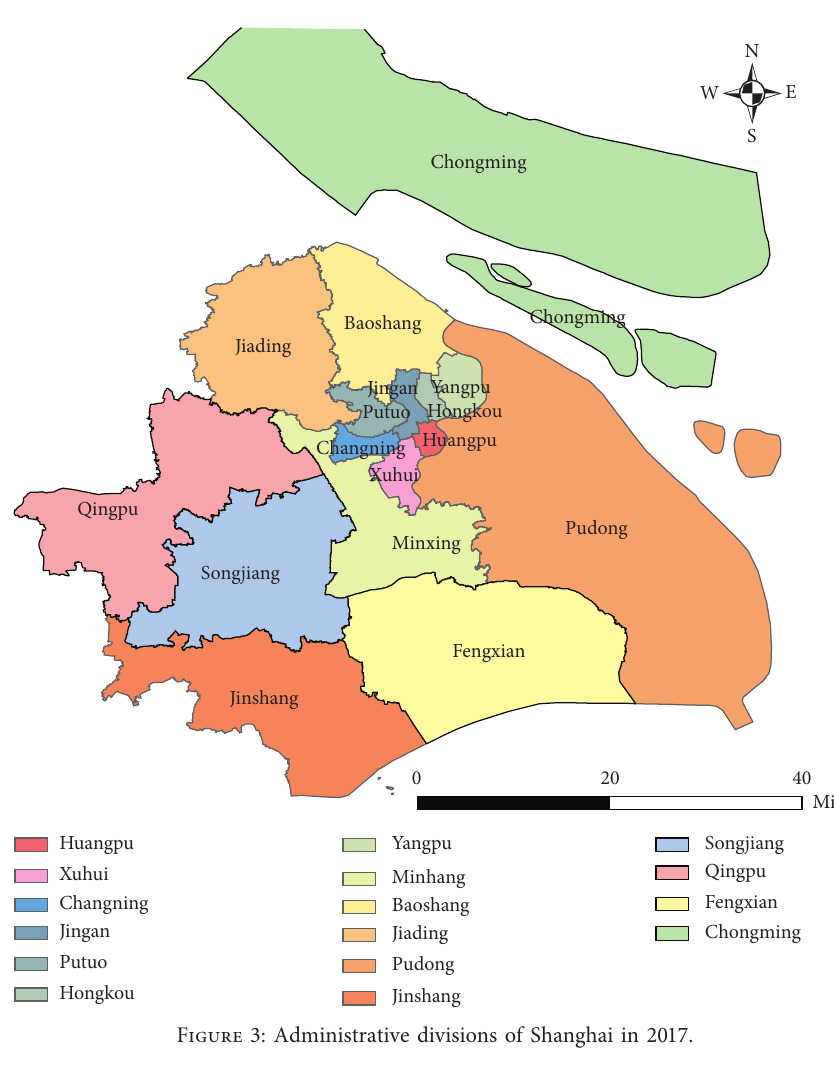
Figure 3: Administrative divisions of Shanghai in 2017.